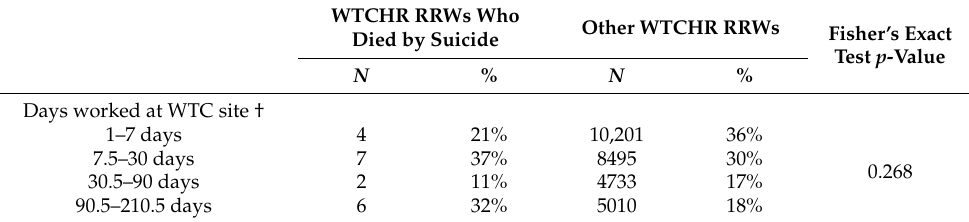
Table 2. 9/11 exposure characteristics of WTCHR RRWs who died by suicide in NYC in 2004–2018 vs. other WTCHR